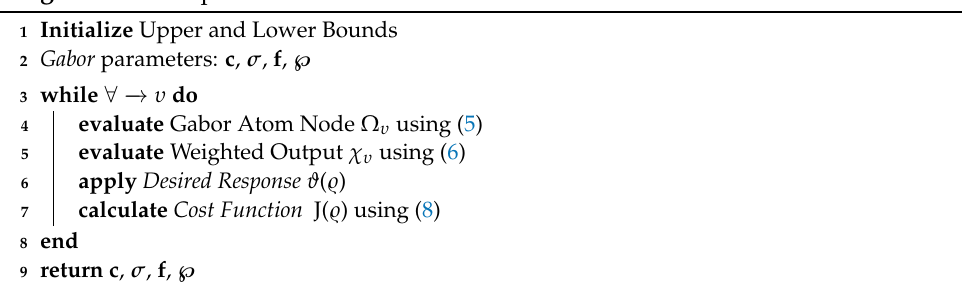
Algorithm 1: Proposed Gabor filter network